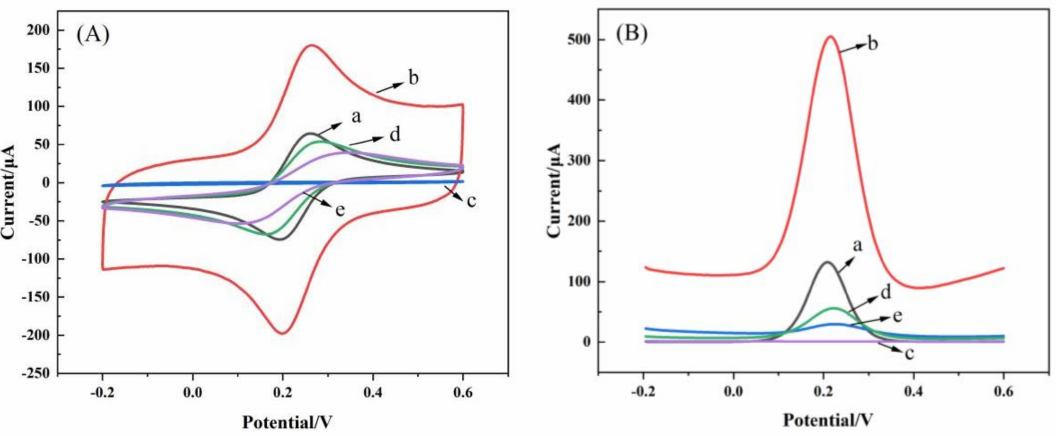
Figure 5. CV ( A ) and DPV ( B ) plots of of 5 mM [Fe (CN) 6 ] 3 − /4 − in 1 M KCl solution at GCE (a), TGC/GCE (b), NOR − MIP/TGC/GCE (c), MIP/TGC/GCE (d) and NORad − MIP/TGC/GCE